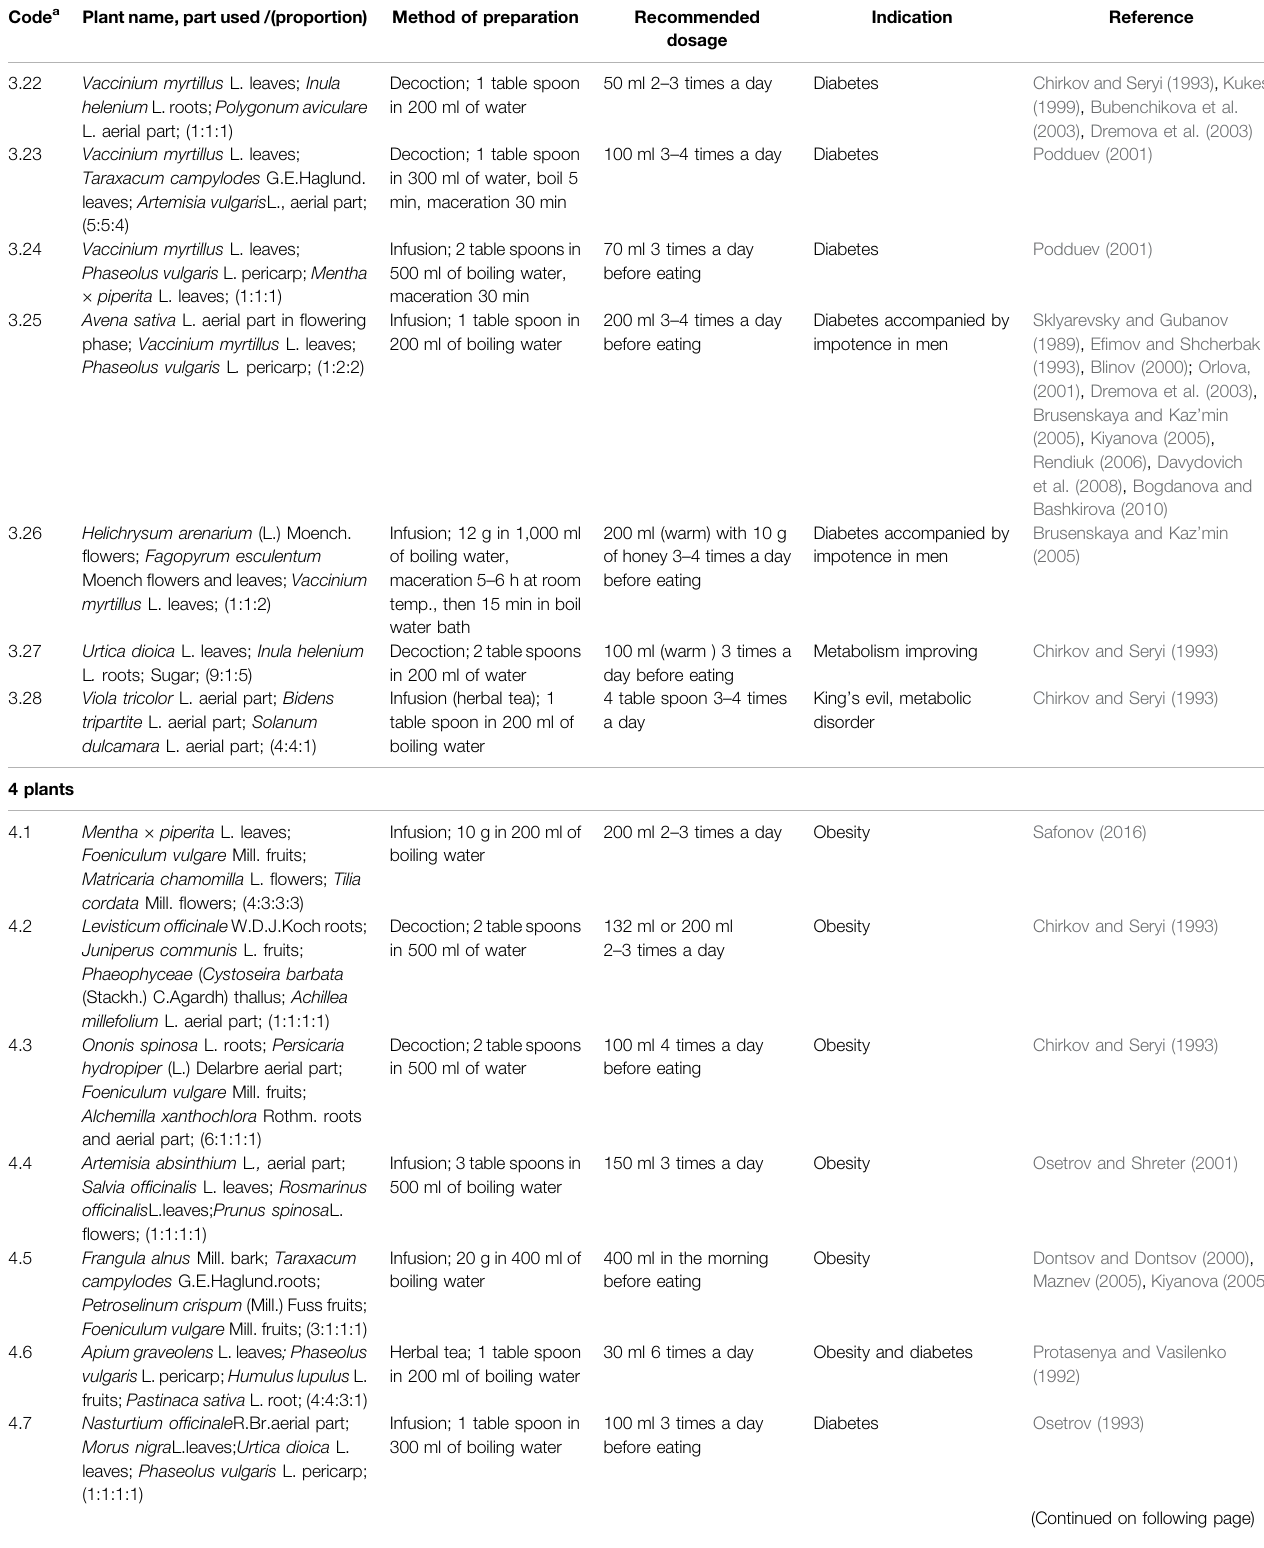
TABLE 1 | ( Continued ) The list of medical species used for the management of diabetes and related disorders in